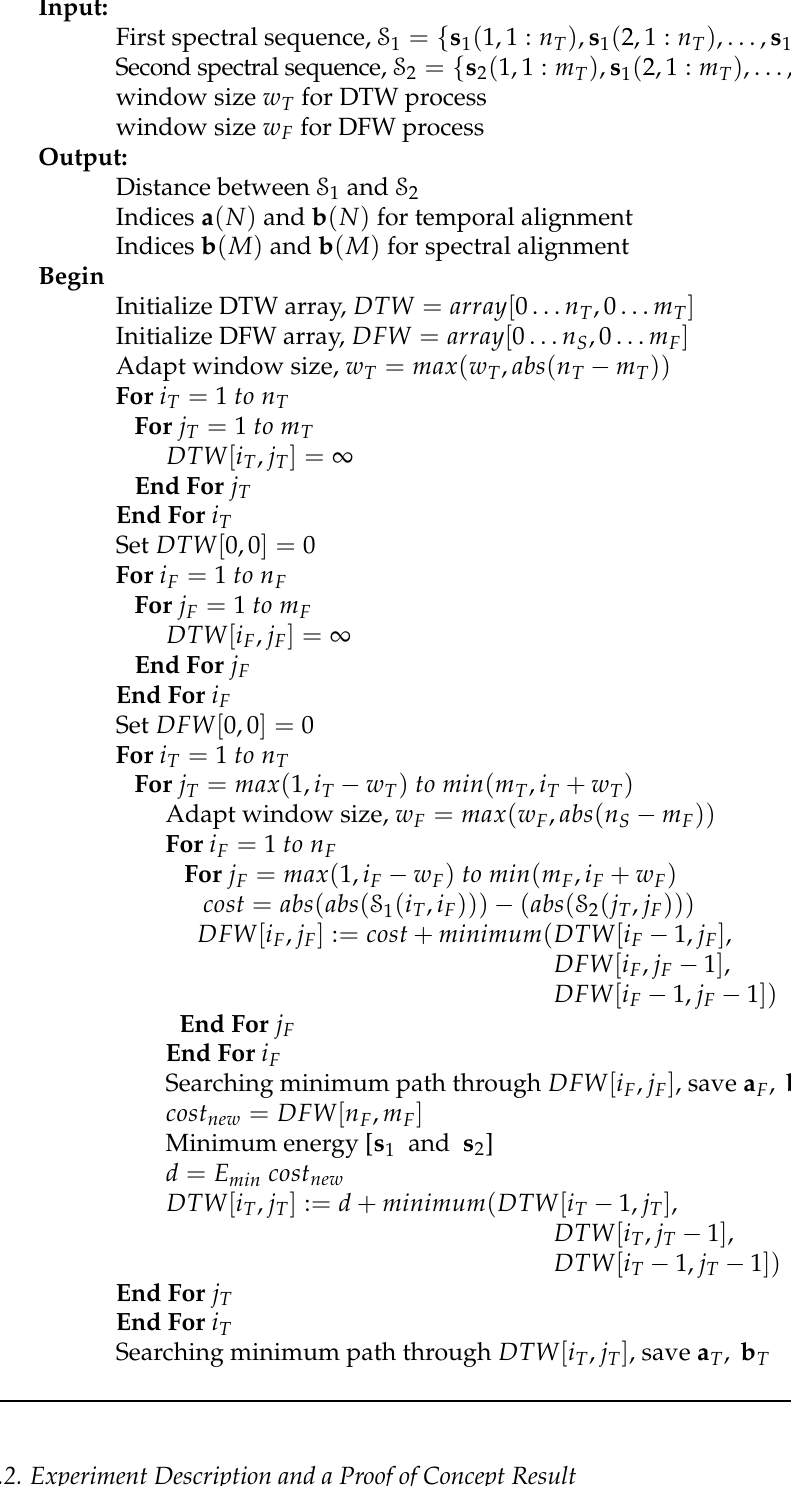
Algorithm 1: Dynamic Warping ( DW ) for Voice